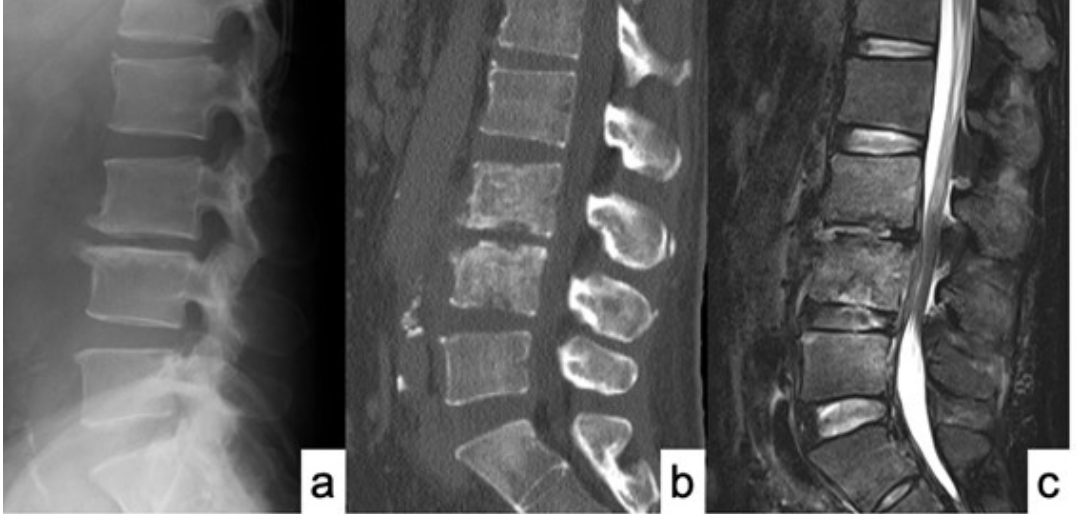
Figure 1. MRI and CT scan of case No. 14 at first admission. ( a ) X-ray of sagittal view; ( b ) Sagittal view of CT scan showed a destructive change of L3 and L4 vertebral bodies; and ( c ) T2-weighted sagittal view of MRI showed spondylodiscitis at L3-4 and L4-5 with epidural abscess.